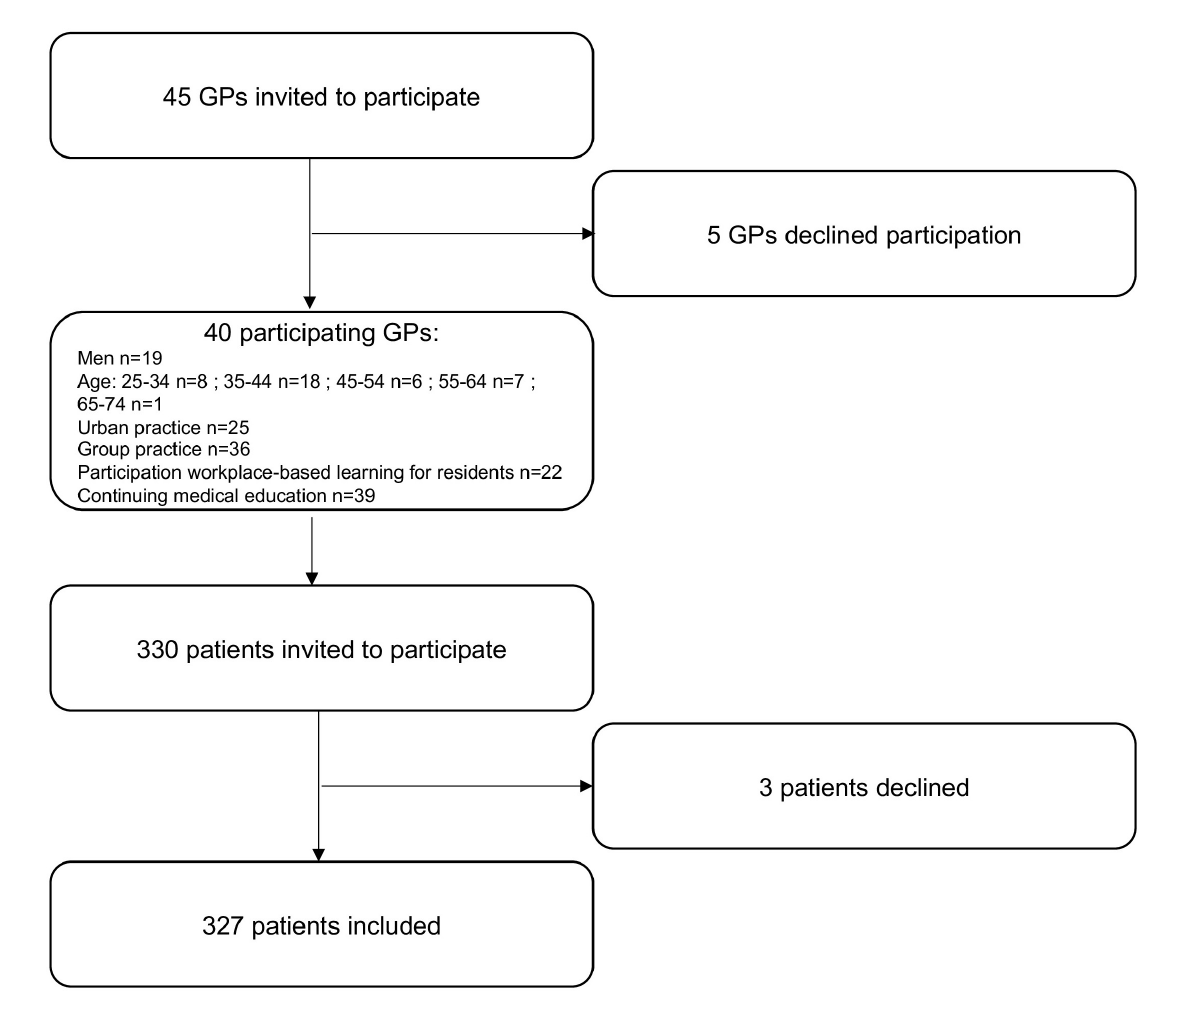
FIGURE1 Flow-chart of general practitioners (GPs) and patients